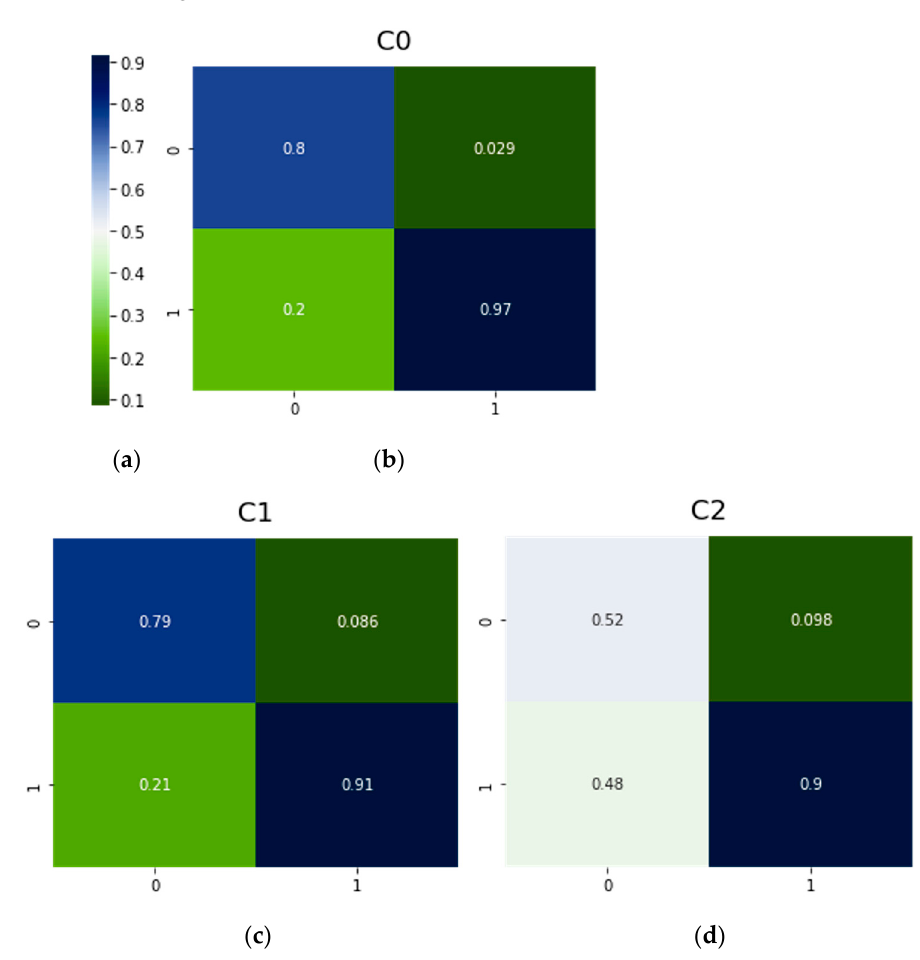
Figure 6. The Logistic Loss curve for the multi-classification model based on Resnet50. As can be seen in Figure 6, the model was also not overtrained because validation LogLoss was decreasing. However, the loss values were still too big. The metrics were not good enough, precision was 0.615, recall was 0.614, and the F1 metric was 0.611. To identify the problems in classification, rated confusion matrices were constructed for each CEAP class (Figure 6).